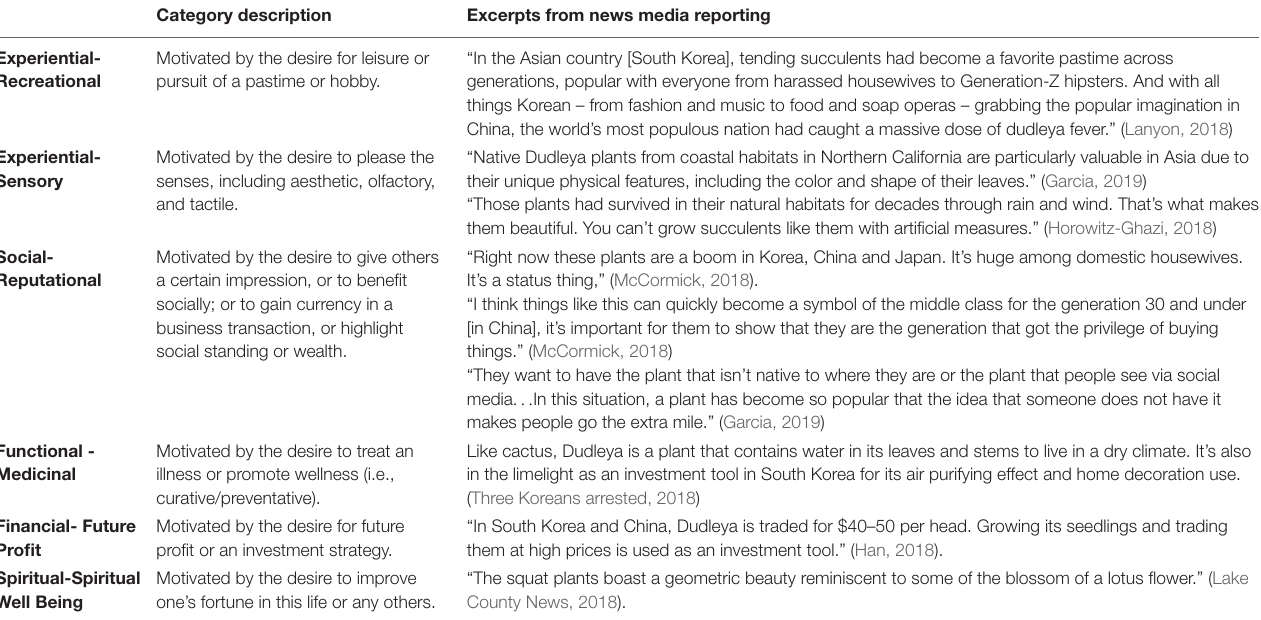
TABLE 2 | Examples of excerpts of news articles coded by sub-categories from the applied framework of Thomas-Walters et al.